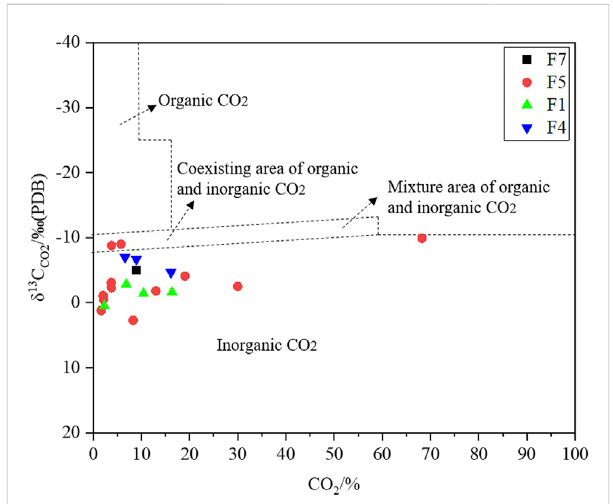
FIGURE 6 Plotof δ 13 C CO2 vs.CO 2 contentofnaturalgasesfromtheShunbei area (Modi fi ed from Dai et al.,